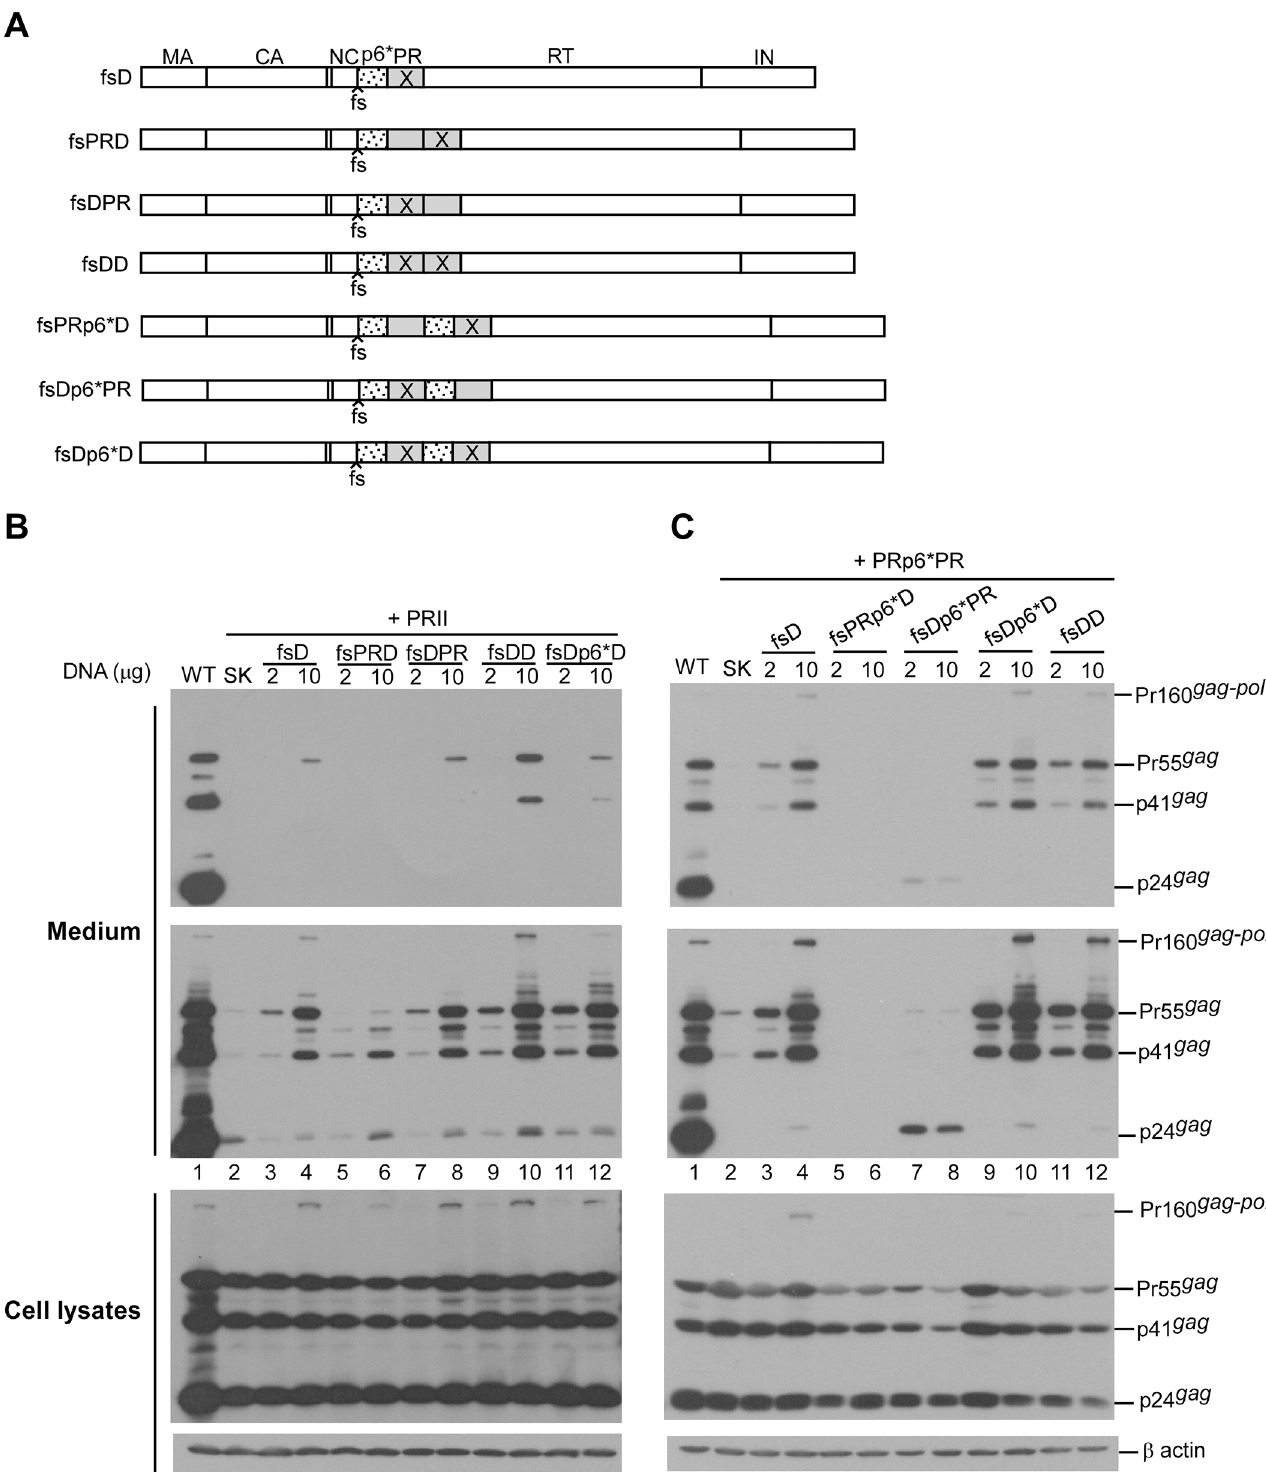
Fig 4. Reduced PRII and PRp6 * PR protease activity due to PR-defective Gag-Pol. (A) Schematic representations of HIV-1 Gag-Pol expression constructs. HIV-1 Gag domains, pol -encoded p6 * , PR, RT and IN are indicated. fs denotes a frameshift mutation that forces gag and pol into the same reading frame. X denotes a PR-inactivated mutation. (B-C) 293T cells were transfected with 10 μ g of PRII or PRp6 * PR plasmids, alone or in combination with 2 or 10 μ g of one of the designated constructs. Plasmid DNA amounts were maintained at 20 μ g by adding pBlueScript SK. At 48 – 72 h post-transfection, culture supernatants and cells were collected and subjected to Western immunoblotting.